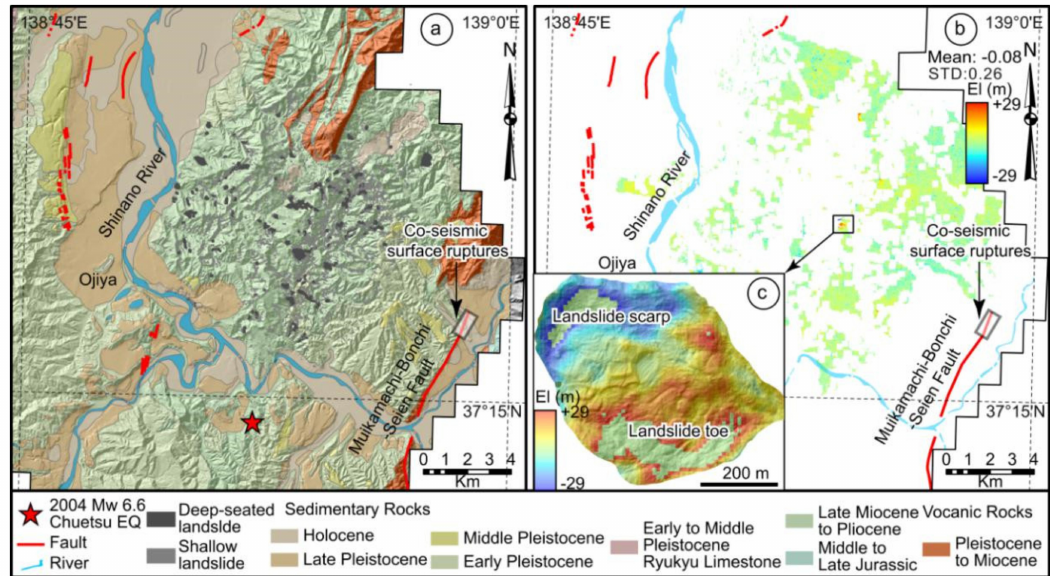
Figure 4. Geological map and distribution of co-seismic landslides ( a ) and elevation changes in the epicentral area ( b ); the inset map shows the largest co-seismic landslide ( c ). The dark grey polygons show deep-seated landslides, and the light grey polygons show shallow landslides. The landslide inventory map is from the National Research Institute for Earth Science and Disaster Prevention (NIED), Japan. The mean elevation change of the landslide region is − 0.08 m with a STD of 0.26 m. The white background indicates a value of zero. The colour scale is shown in